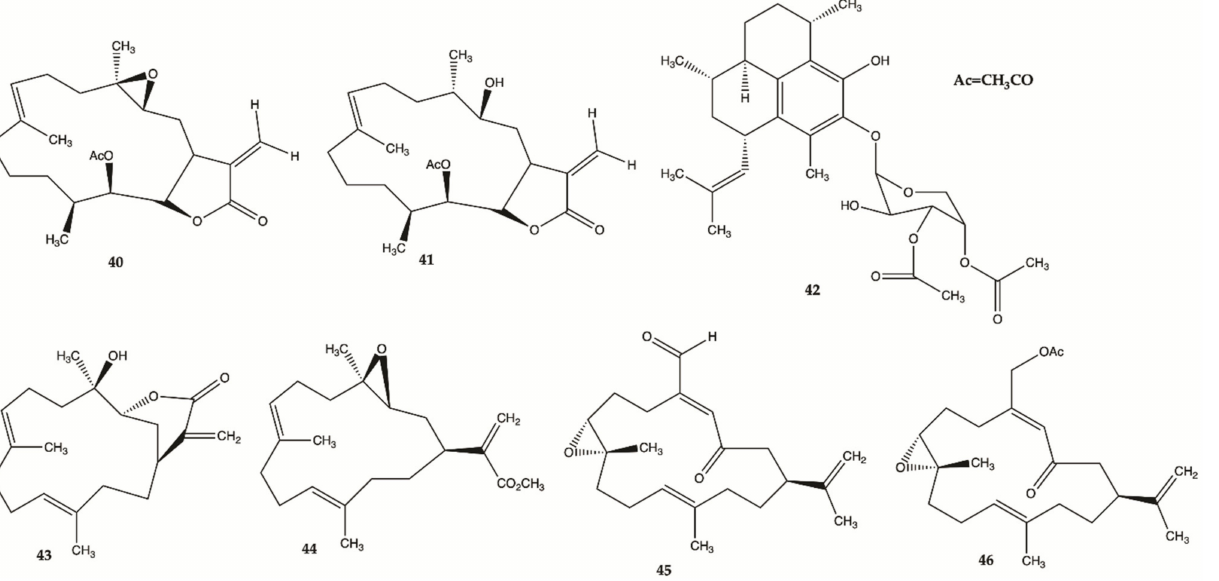
Figure 16. Polyketides 40 – 46 isolated from Caribbean Octocoral Eunicea succinea [52].